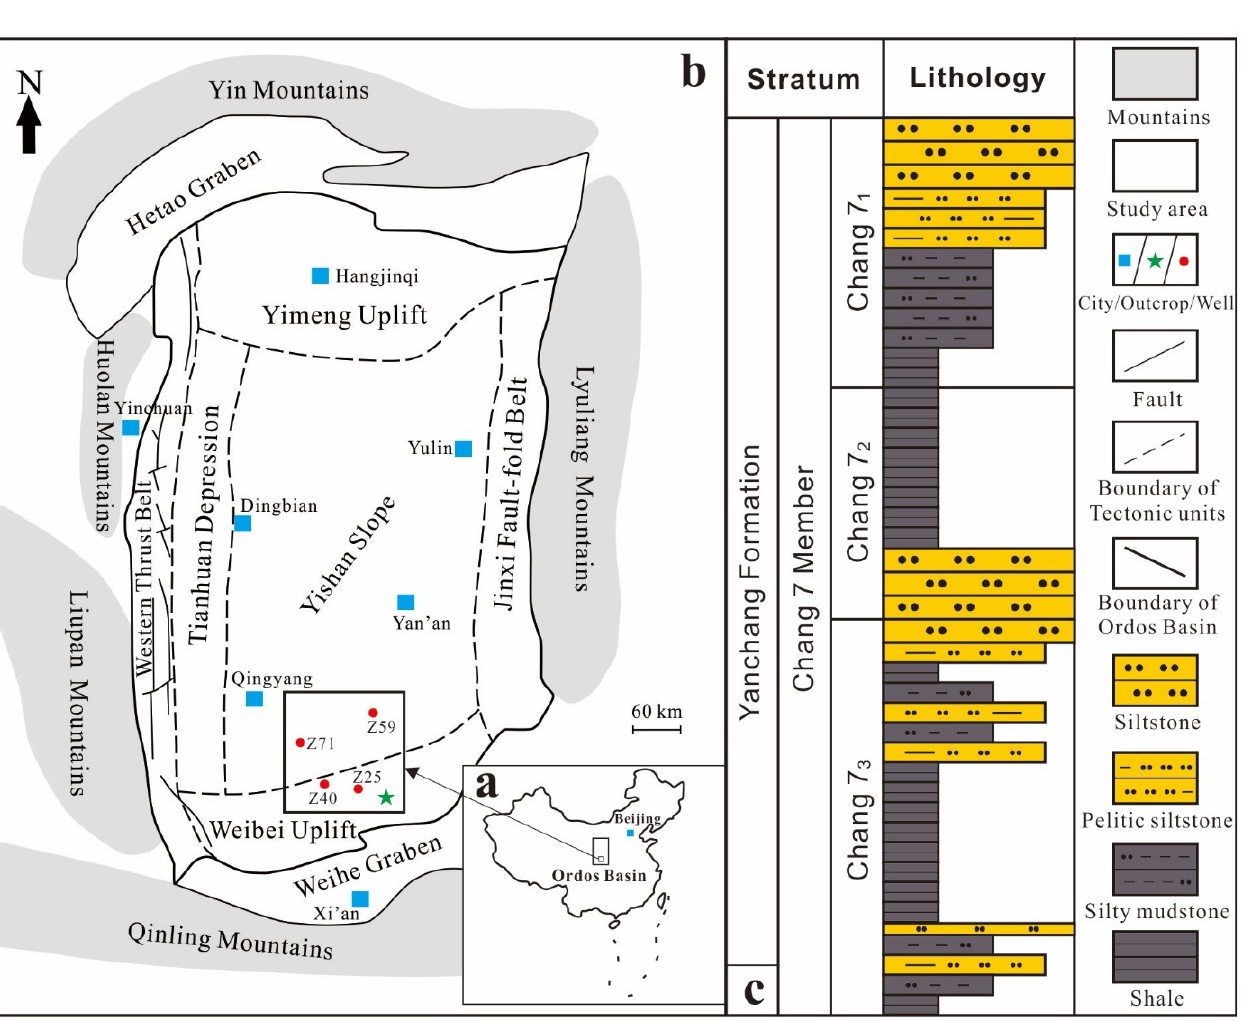
Figure 1. Location map of the area and lithology column of the sampling well. ( a ) Location of the Ordos Basin in China; ( b ) outline and sampling location of this study in Ordos Basin; ( c ) stratigraphic scheme and lithology of the Chang 7 Member in Ordos Basin.